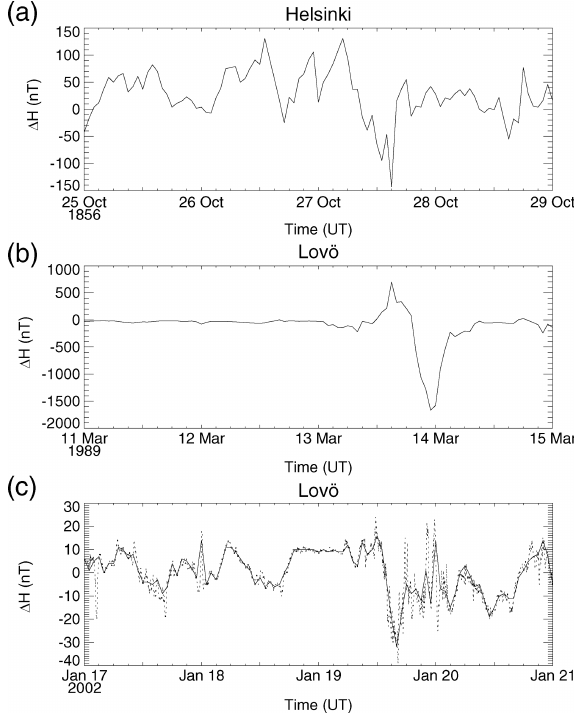
Figure 3. From (a) to (c) , the H component of the geomagnetic field disturbance at Helsinki in 1859, Lovö in 1989, and Lovö in 2002. The dotted line indicates the 1min